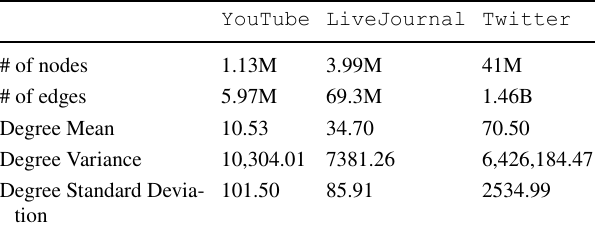
Table 2 Zipf–Mandelbrot parameters for graph